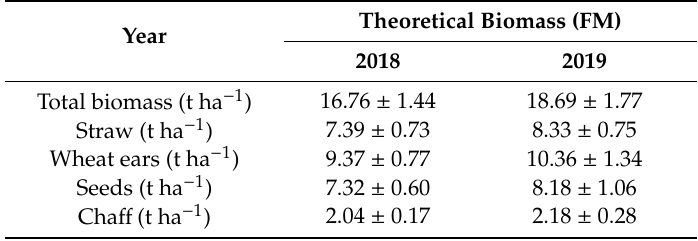
Table 6. Theoretical biomass in the wheat field assessed in 2018 and